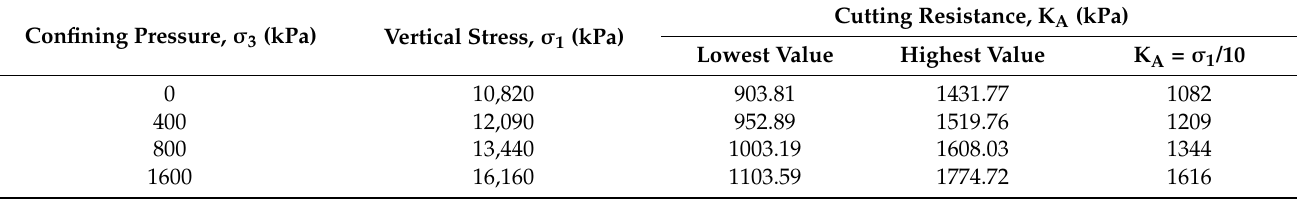
Figure 19. Relationship between cutting resistance, K A , and vertical stress, σ 1.